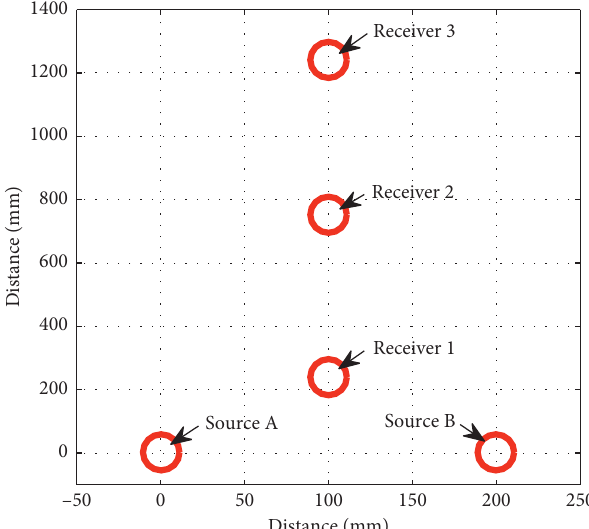
Figure 23: Positions of the different receivers and the sources in the virtual